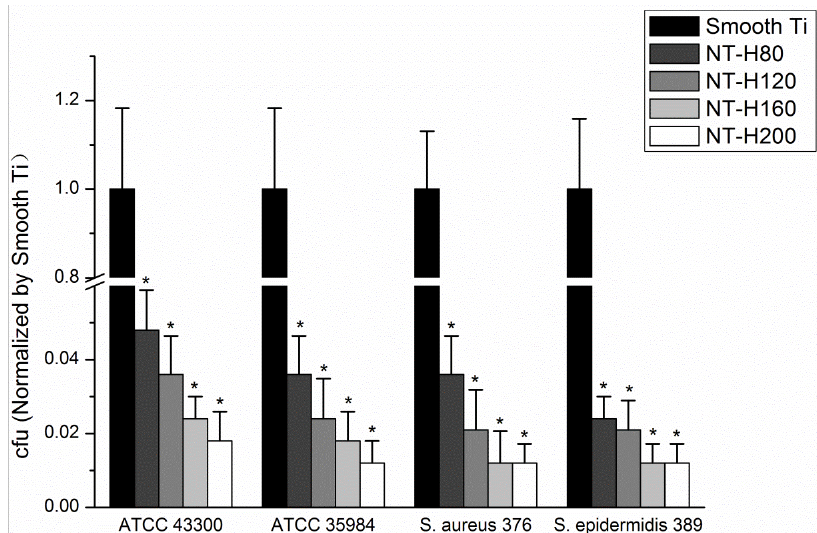
Figure 3. The number of viable bacteria adhered on Smooth Ti and NT ‐ H surfaces at 6 h. The number of viable bacteria was counted and normalized to the counts from the Smooth Ti control for each bacterial strain. * denotes a significant difference compared to Smooth Ti ( P < 0.01).